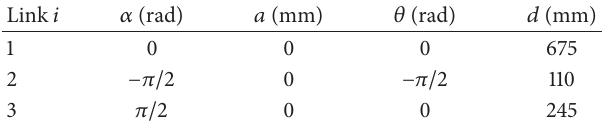
Table 1: The D-H parameters of the manipulator.